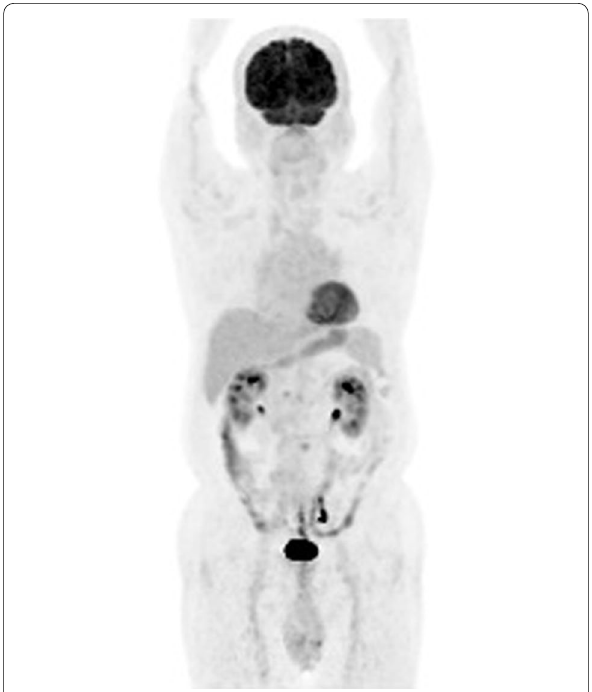
Fig. 4 Image of F-18–2-fluoro-2-deoxy-D-glucose positron emission tomography computed tomography. No other affected organs were detected in the whole-body imaging